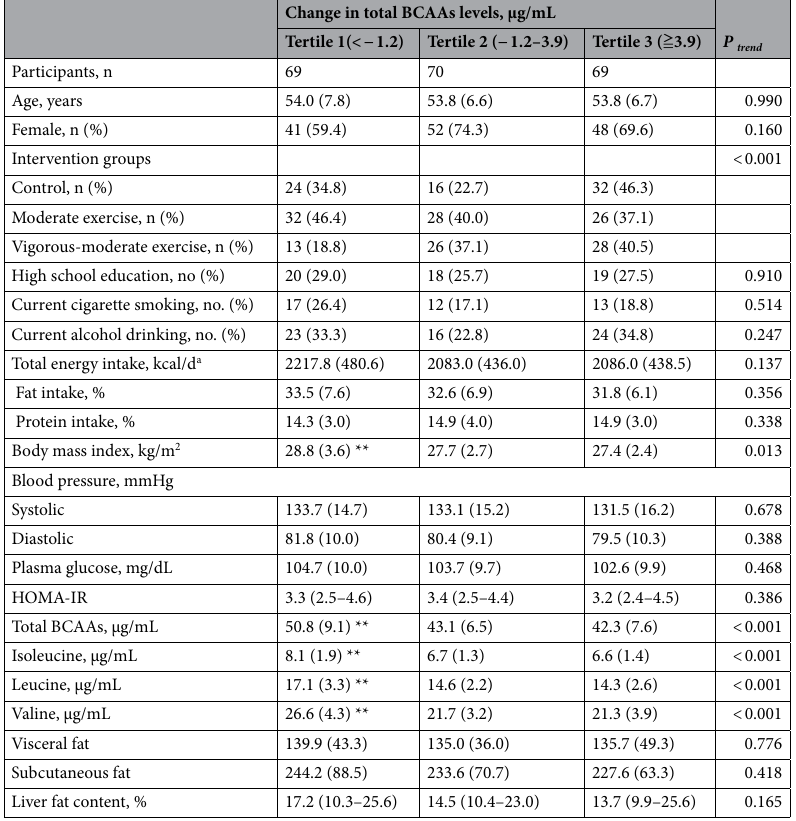
Table 1. Baseline characteristics according to the tertiles of change in serum total BCAAs a levels. Data are presented as mean (SD), unless otherwise indicated. a: Tertiles were categorized based on change in total BCAAs level from baseline to 6 months. Abbreviations: IQR interquartile range; HOMA-IR homeostatic model assessment of insulin resistance. **: p < 0.01 vs.